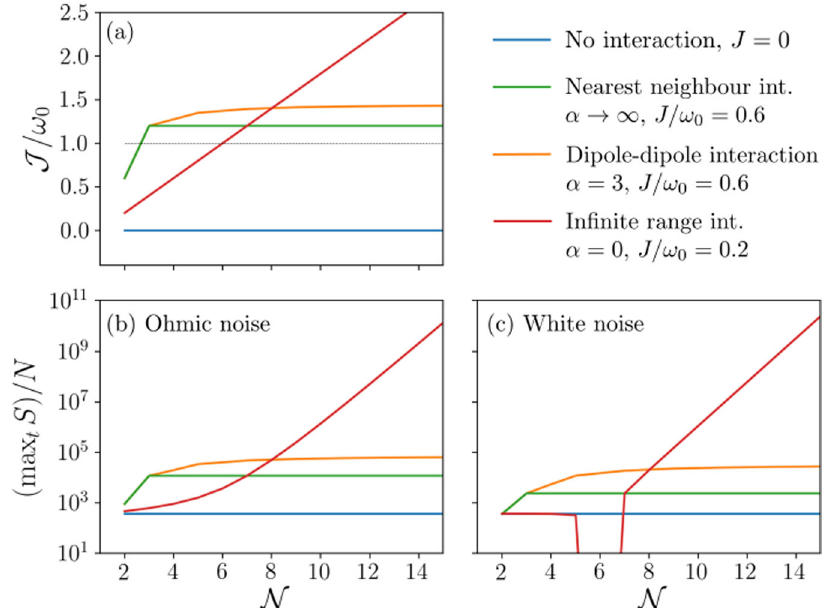
Fig. 3 a For short-range interactions (blue, green and orange lines), the collective coupling strength J = ω 0 is relatively constant for N > 3 . b , c If the coupling is short-range, the sensitivity is already close to its maximum value for small cluster size. If the coupling is long-range, however, sensitivity can increase with N . ( b is for Ohmic spectral density f ( Ω ) = 0.001 × Ω ; c is for white noise f ( Ω ) = 0.001. Both assume β = 10/ ħ ω 0